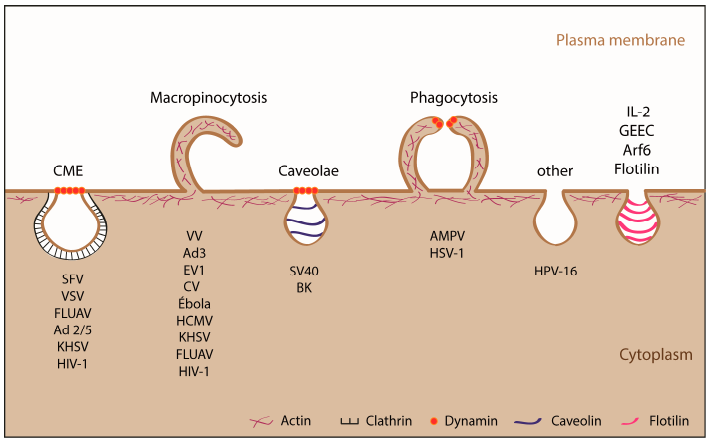
Figure 1. Endocytic mechanisms used by animal viruses. In general viruses smaller than 150 nm internalize by clathrin-mediated endocytosis (CME) or caveolae mechanisms, whereas those larger than 150–200 nm use macropinocytosis or phagocytosis. Other mechanisms such as Arf-6, IL-2, flotilin and GPI-AP enriched early endosomal compartment (GEEG) are less commonly used by viruses to enter into cell. It is important to note that some viruses can enter the cell through more than one type of endocytosis. SFV, Semliki Forest Virus; VSV, Vesicular Stomatitis Virus; FLUAV, Influenza A Virus; Ad2/5, Adenovirus 2 and 5; KHSV, Kaposi Sarcoma-associated Herpesvirus; HIV-1, Human Immunodeficiency Virus; VV, Vaccinia Virus; Ad3, Adenovirus 3; EV1, Echovirus 1; CV, Coxsackie Virus, HCMV, Human Cytomegalovirus; SV40, Simian Vacuolating Virus 40; BK, Virus BK; AMPV, Mimivirus; HSV-1, Herpes Simplex Virus; HPV-16, Human Papillomavirus 16. Adapted from [36]. Due to the restrictions imposed by the large size of the ASFV viral particle (200 nm), CME was not initially considered to be the most probable mechanism for viral entry, as it is more commonly used by smaller viruses such as the Adenovirus 2/5 [26,37] and Semliki Forest Virus [38]. Nevertheless, TEM studies have detected ASFV viral particles within dense, possibly clathrin-coated membrane invaginations and vesicles in Vero cells infected with the Ba71V isolate, and in swine alveolar macrophages infected with the E70 isolate [1,39]. Moreover, it has been reported that expression of the early viral protein p32 is inhibited by the expression of Eps15 and dynamin-2 dominant negative in Vero cells infected with Ba71V [40]. In that study, about 60% of the viral particles colocalized with the heavy chain of clathrin during the first 20 min of internalization, and the expression of p32 was inhibited when the cells were treated with dynasore (specific inhibitor of dynamin) and chlorpromazine (CPZ; CME inhibitor). In contrast, another study showed that in the same experimental model, viral uptake was only partially reduced with dynasore treatment but not with CPZ, although the expression of viral proteins was inhibited by both treatments [41], suggesting that CPZ may affect later stages of viral entry. These controversial data may possibly be explained by differences in the experimental approaches used in these two studies. Further clarification was obtained from two studies reporting that different viral isolates, such as Ba71V, 608V13 and E70, use CME to internalize into porcine alveolar macrophages [39,42]. While ASFV uptake was reduced in a dose-dependent manner after treatment with specific inhibitors of CME, including dynasore, CPZ and pitstop2, the authors could not rule out that some of these treatments have side effects that may have affected other viral processes. Moreover, 25% of the viral particles were localized to vesicles along with transferrin, a specific fluid phase marker of CME, and the expression of early viral protein p32 was compromised when PAM were transfected with siRNAs specific for the clathrin-heavy chain [39], supporting that CME has some role in virus entry.